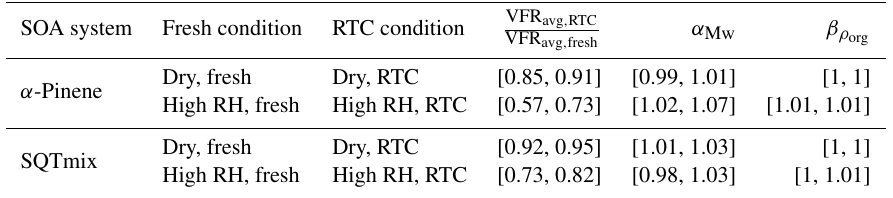
Table C1. Ranges of parameters for scaling the normalized sum thermograms of RTC stages. SOA system